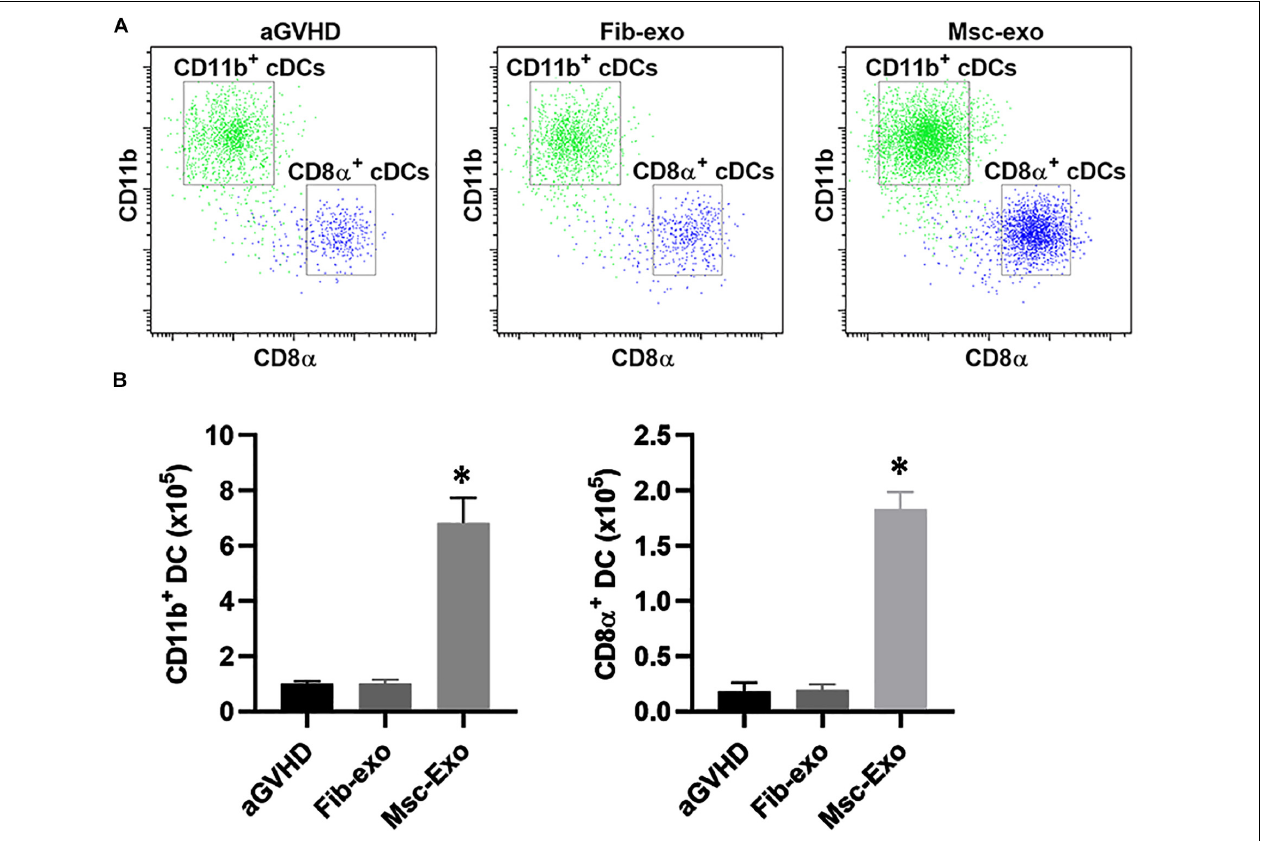
FIGURE 2 | Effect of Msc-exo on the dendritic cell (DC) subpopulation in acute graft-versus-host disease (aGVHD) mice. aGVHD mice were injected with either Fib-exo or Msc-exo via tail vein, and the number of CD11b + and CD8 α + conventional dendritic cells (cDCs) in the spleen was analyzed by flow cytometry 10 days after exosome injection. (A) Representative plots showing the ratio of CD11b + and CD8 α + cDCs. (B) CD11b + and CD8 α + cDCs in the spleen were enumerated 10 days after exosome injection. Data were representative of three independent experiments where n = 5 in each group. ∗ p <